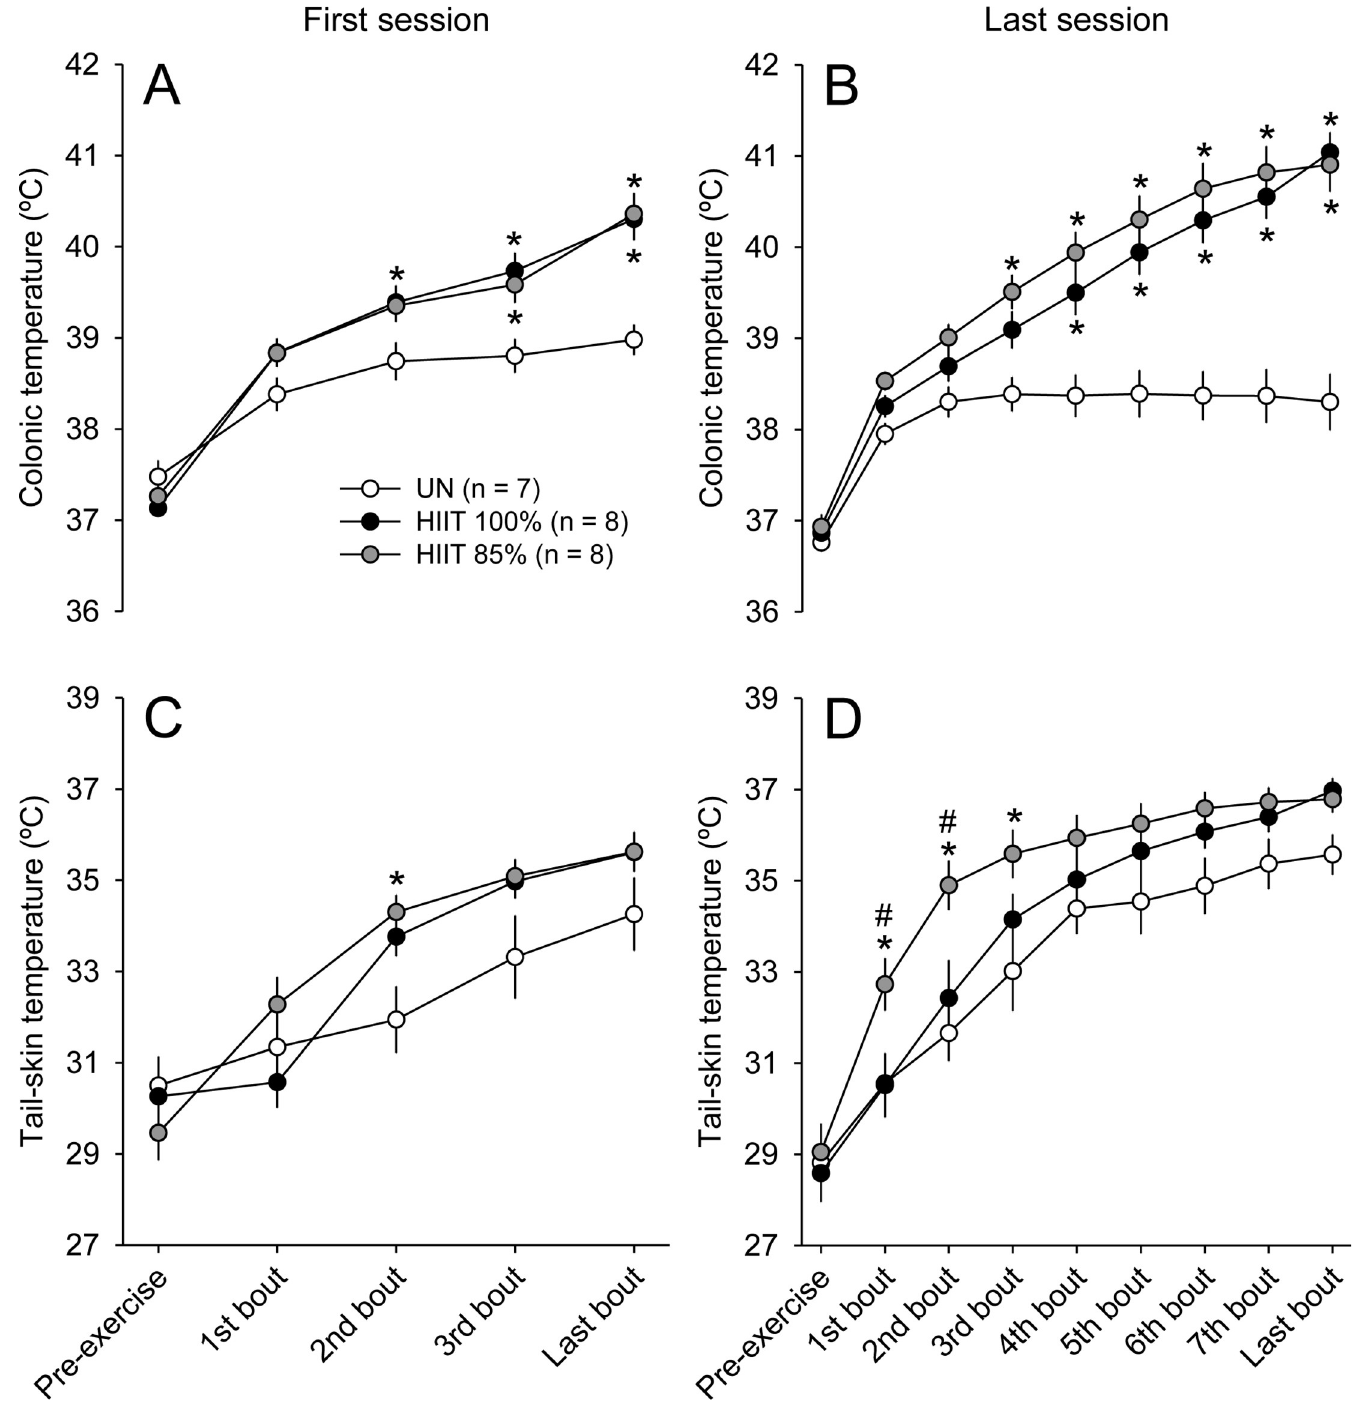
Fig 2. Colonic temperature (T COL ; panels A and B) and tail-skin temperature (T TAIL ; panels C and D) in rats of the three experimental groups during the first (A and C) and last (B and D) heat acclimation sessions. The values are expressed as the means ± SEM. HIIT 100% : high-intensity interval training at 100% of maximal speed; HIIT 85% : high-intensity interval training at 85% of maximal speed; UN: untrained, passive heat exposure. � denotes a significant difference from the UN group in the same bout (p < 0.05); # denotes a significant difference from the HIIT 100% group in the same bout (p < 0.05).